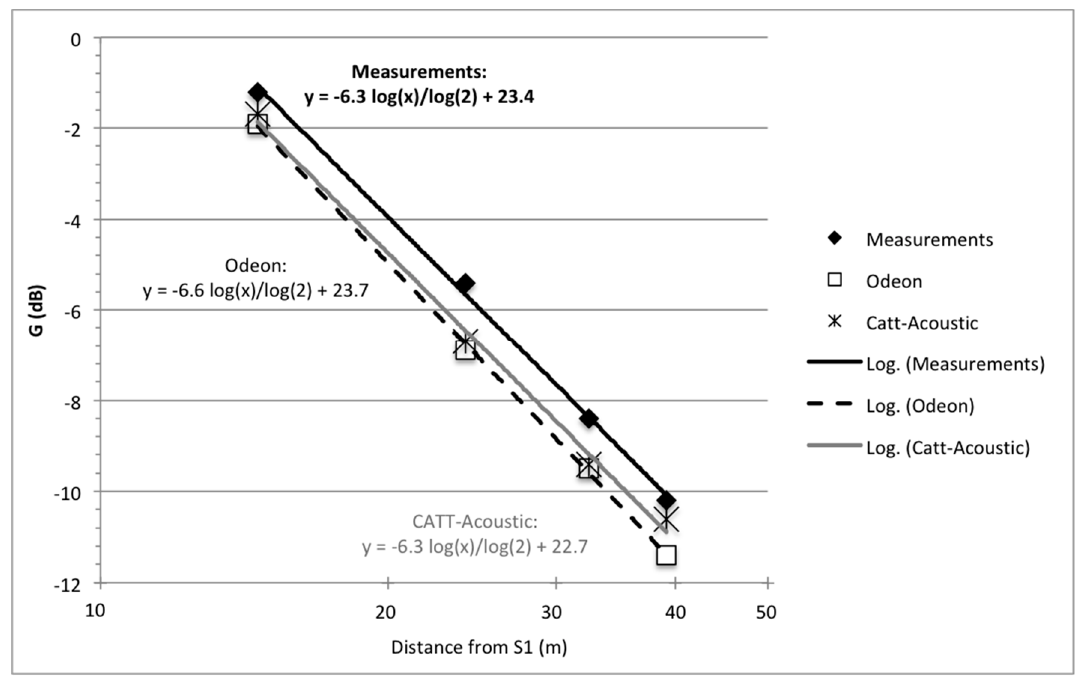
Figure 5. G values averaged over the central 500 Hz and 1 kHz octave-band frequencies, and for each row, represented along the average distance from the source, derived from the measurements and from the simulations with Odeon and CATT-Acoustic.